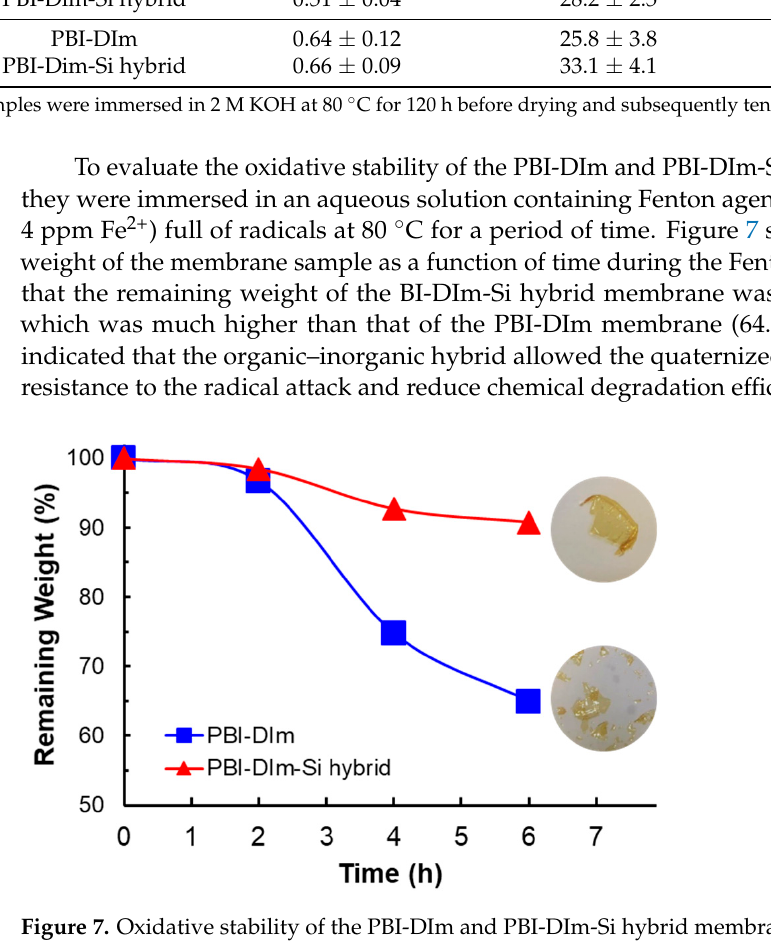
Table 2. Mechanical properties of the PBI-DIm and PBI-DIm-Si hybrid membranes.